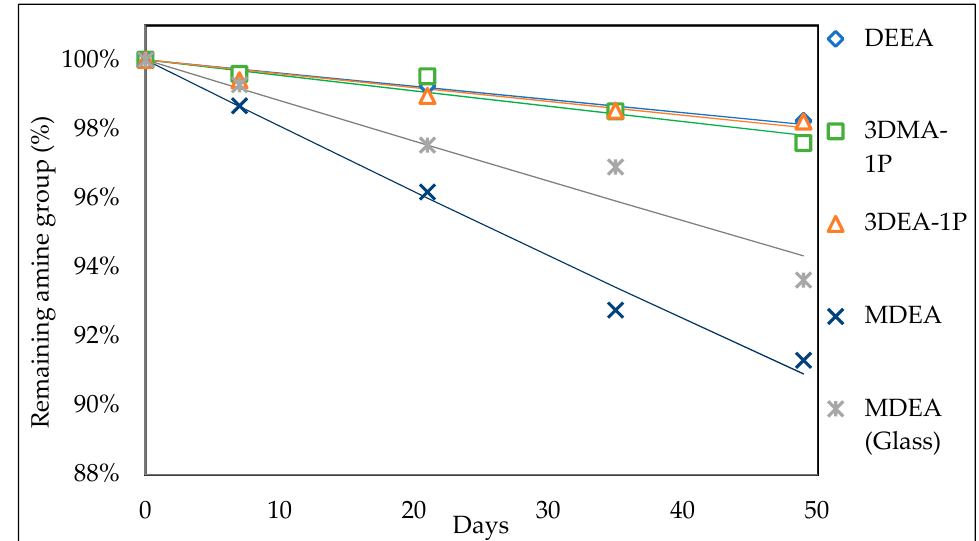
Figure 6. Remaining amine group concentration in amine triethylene glycol (TEG) blends, with solid lines representing the model results; unloaded amine wt.% = 30; CO 2 loading ≈ 0.1.